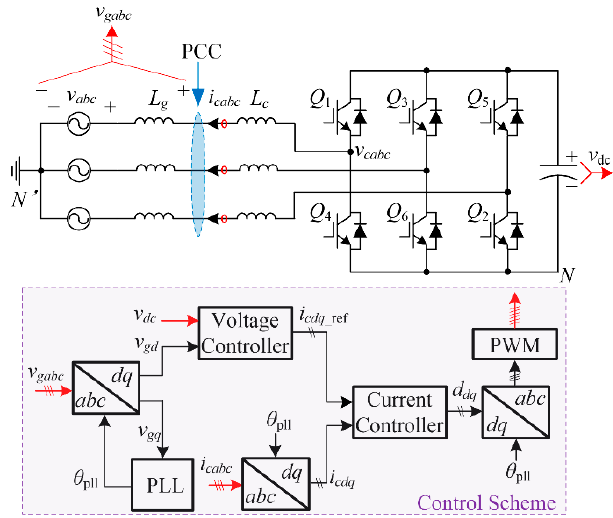
Figure 1. System schematic and control scheme of DSTATCOMs.